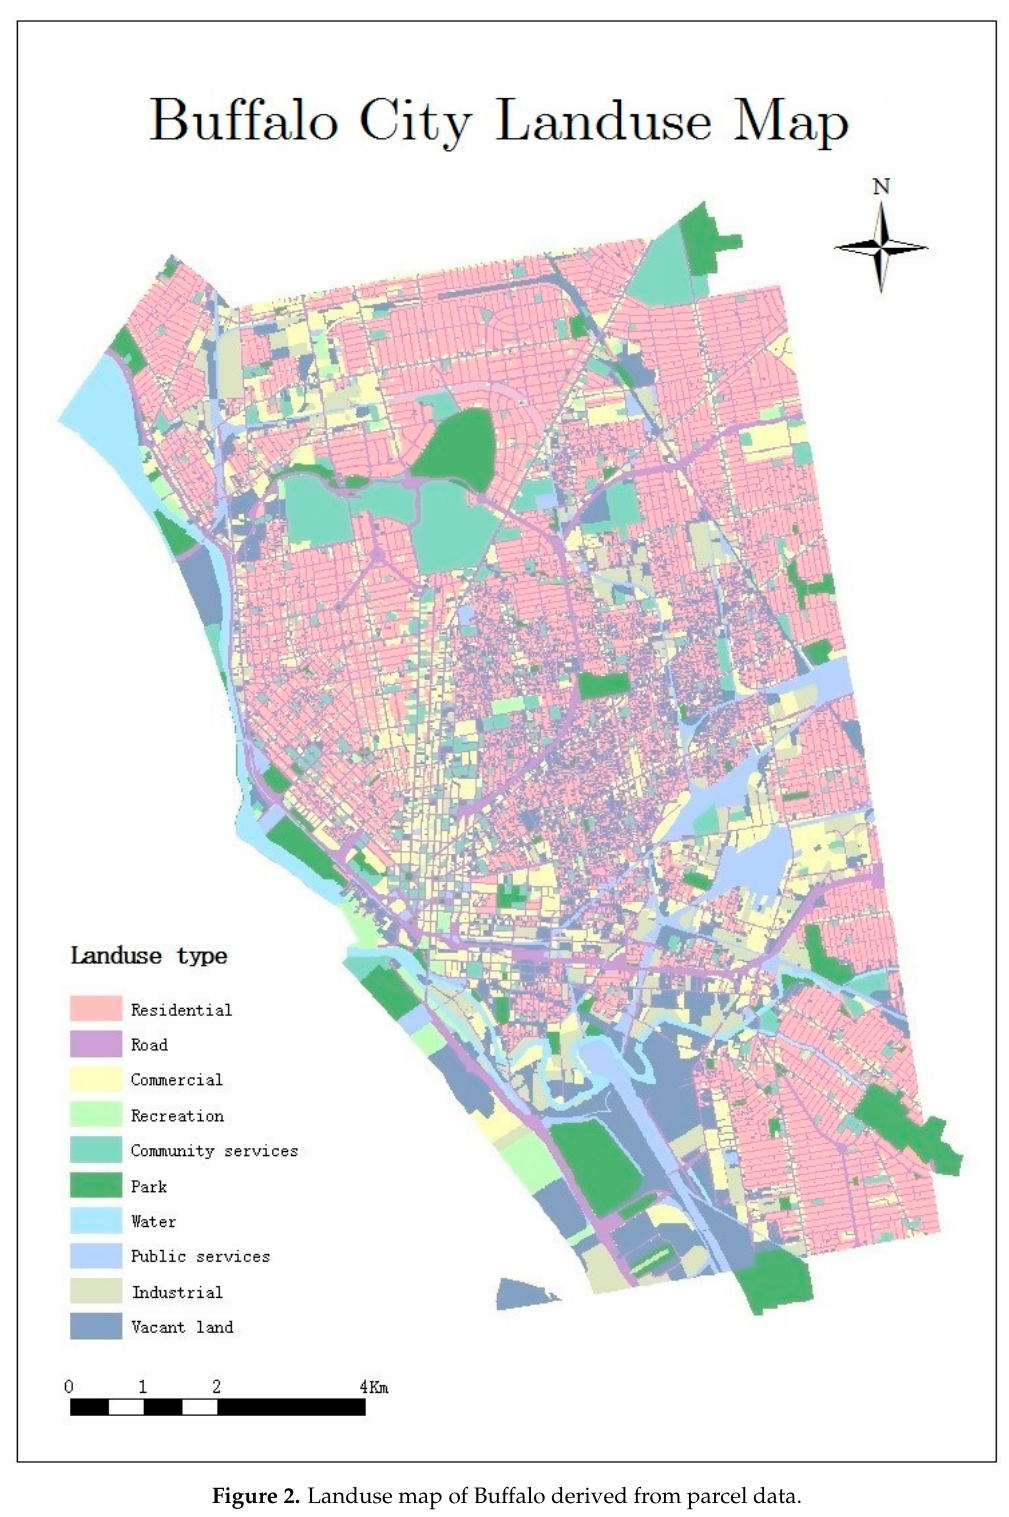
Figure 2. Landuse map of Buffalo derived from parcel Figure2. Landuse map of Buffalo derived from parcel data.